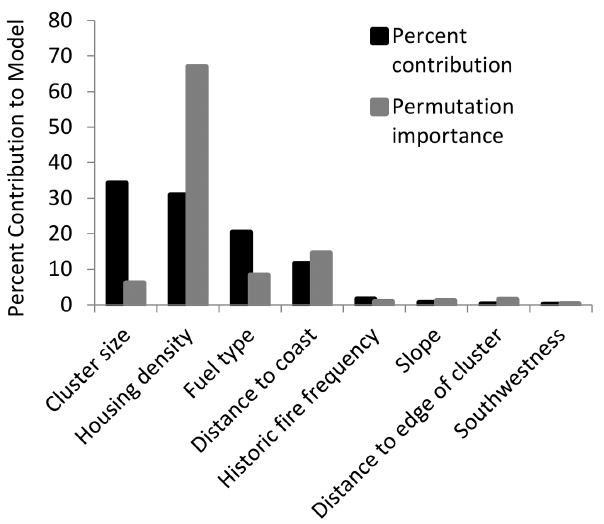
Figure 3. The importance of explanatory variables averaged across five cross-validated replications in the MaxEnt fire risk model. Percent contribution is determined as a function of the information gain from each environmental variable throughout the MaxEnt model iterations. Permutation importance reflects the drop in model accuracy that results from random permutations of each environmental variable, normalized to percentages.